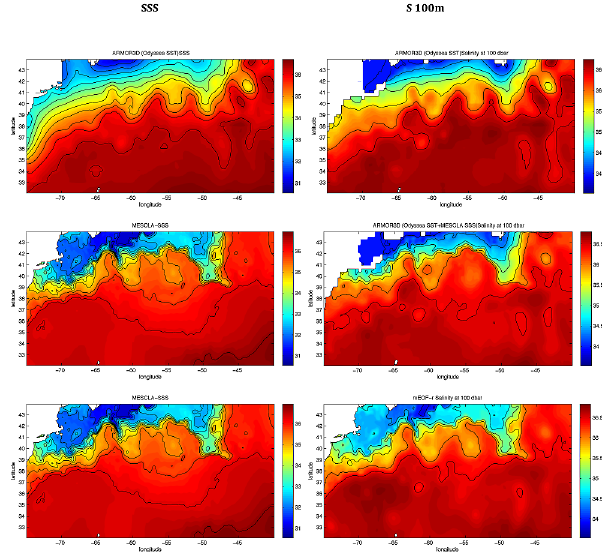
Fig. 9. SSS (left panels) and salinity at 100m (right panels) from the three reconstruction methods selected (from top to bottom): ARMOR3D using ODYSSEA L4 SST as input, ARMOR3D using ODYSSEA L4 SST and MESCLA SSS as input, and mEOF-r( T - S - SH) SSS-SSH